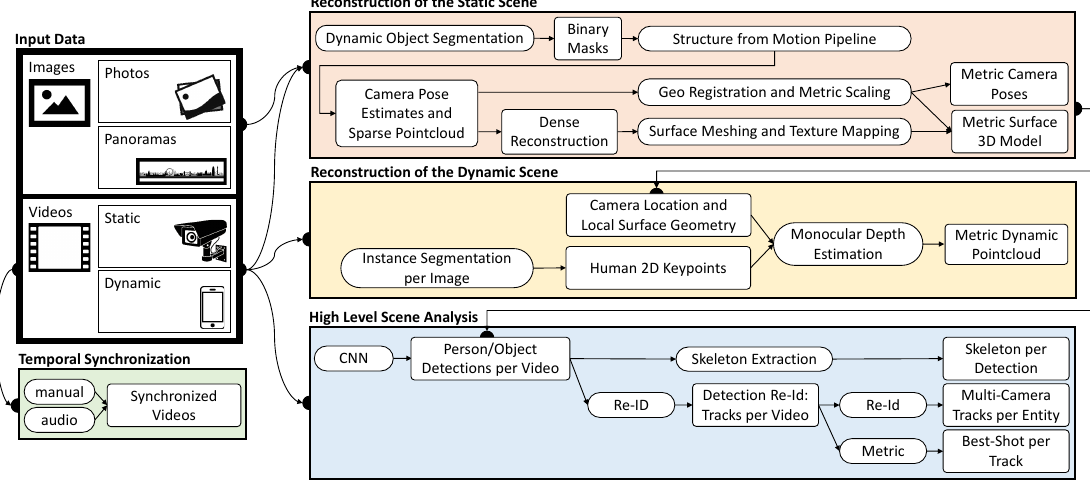
Figure 1. Processing pipeline of the crime scene analysis framework. Multimedia input data are processed in three main steps: First, a static reconstruction of the crime scene is created using a structure-from-motion approach. Second, dynamic elements are extracted as dynamic point clouds. Third, tracks of persons and objects are extracted using machine learning